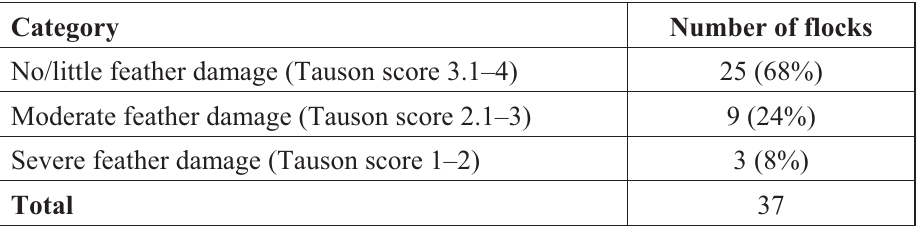
Table 9. Severity of feather damage according to Tauson et al.